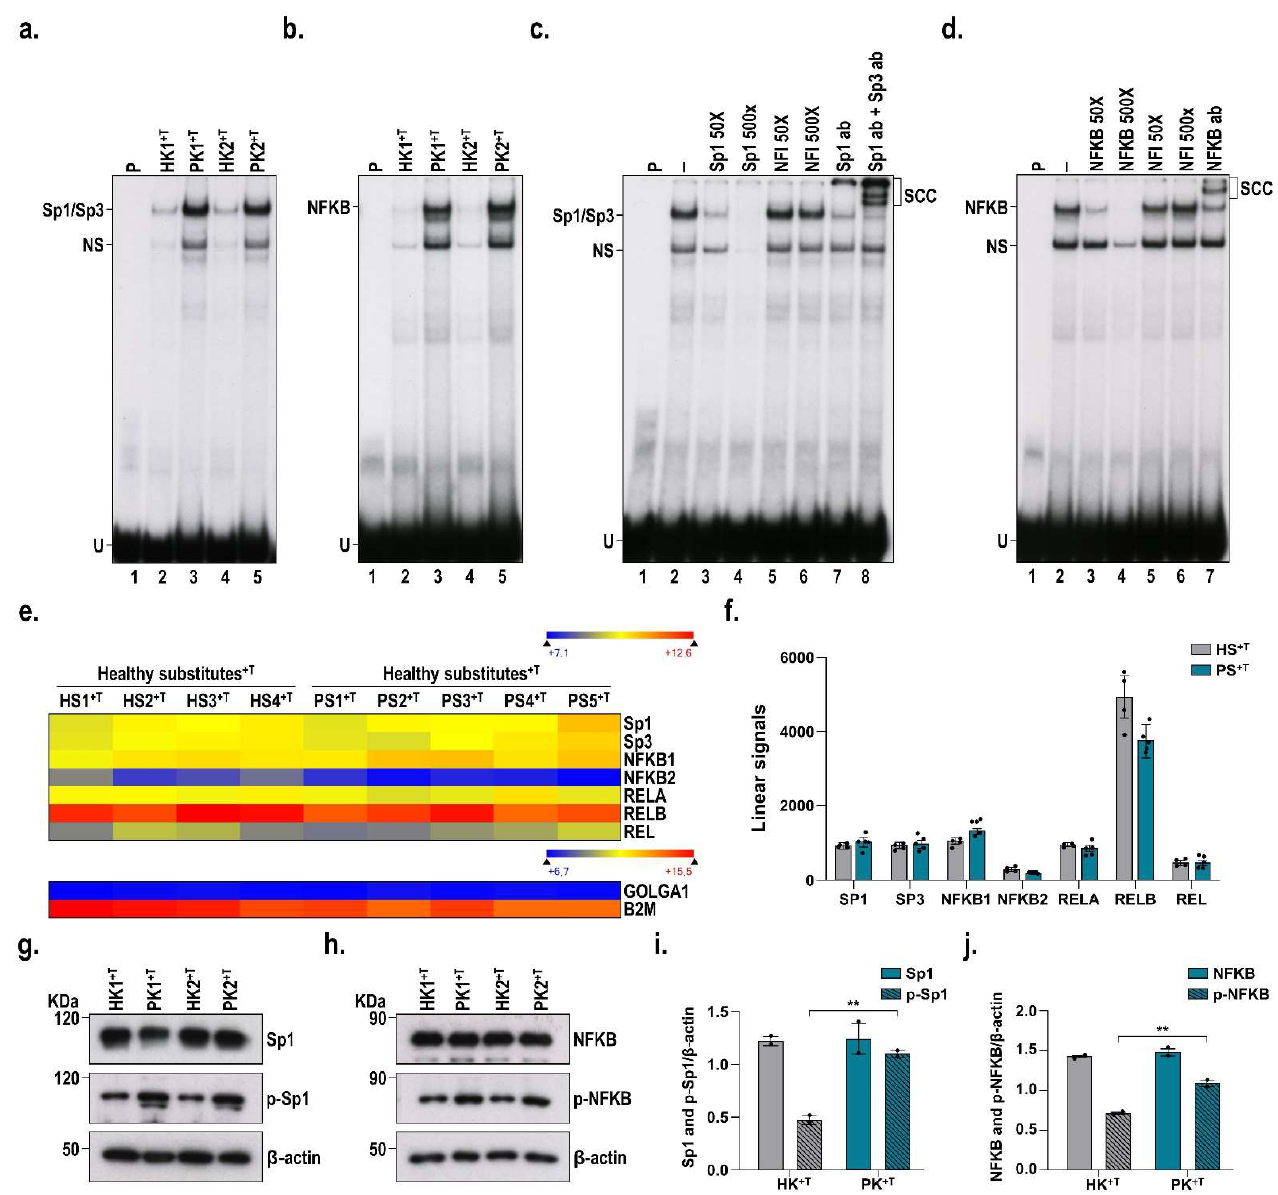
Figure 5. DNA-binding properties of Sp1 and NF- κ B in healthy and psoriatic conditions. Elec- trophoretic mobility shift assays showing the DNA-binding of ( a ) Sp1 and ( b ) NF- κ B in nuclear extracts prepared from monolayers of either healthy (HK +T ) or psoriatic (PK +T ) keratinocytes stimu- lated with T cells. When indicated, 50- and 500-fold molar excesses of unlabeled oligonucleotides for Sp1 (( c ); lines 3 and 4), NF- κ B (( d ); lines 3 and 4) and NFI (( c ); lines 5 and 6, ( d ); lines 5 and 6) were also added as unlabeled competitors. Antibodies directed against Sp1 and Sp1/Sp3 (( a ); lines 7 and 8) as well as against NF- κ B (( b ); line 7) allowed the detection of their corresponding supershifted complexes. Heatmap representation ( e ) and associated linear signals ( f ) of the changes in NF- κ B and Sp1 gene expression between HS +T and PS +T . Western blot analyses for both phosphorylated and non-phosphorylated forms of ( g ) Sp1 and ( h ) NF- κ B were performed using nuclear extracts from monolayers of HK +T and PK +T . Densitometric analysis of the immunoblots for ( i ) Sp1 and ( j ) NF- κ B. Statistical significance was determined using one-way ANOVA followed by Tukey’s post hoc test, ** p < 0.05. HK +T , healthy keratinocytes stimulated with T cells; PK +T , psoriatic keratinocytes stimu- lated with T cells; HS +T , healthy skin substitutes with T cells; PS +T , psoriatic skin substitutes with T cells; P, labeled probe alone; U, unbound fraction of the labeled probe; SSC, supershift